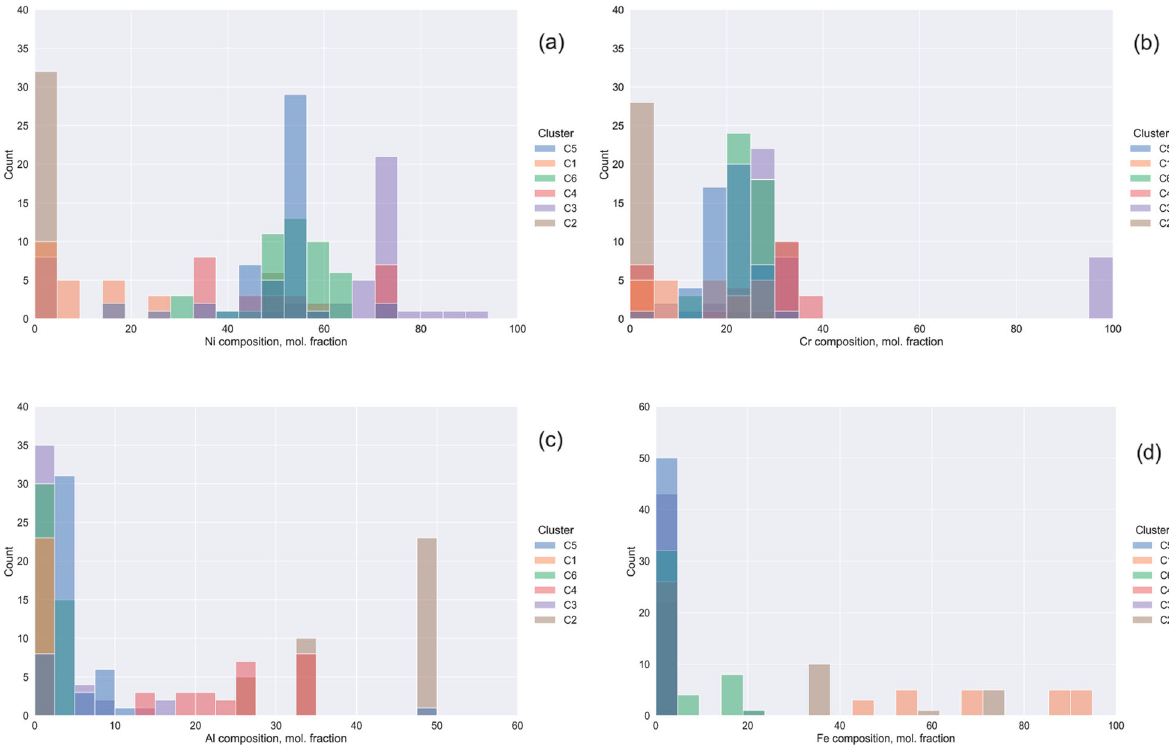
Fig. 6 Alloy distributions according to Ni, Cr, Al, and Fe content. Alloy distributions according to Ni, Cr, Al, and Fe content for the six clusters identi fi ed in the k-means